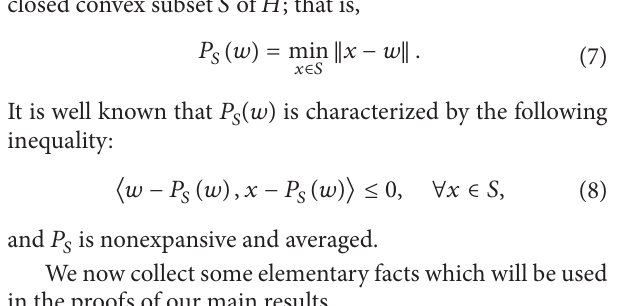
Algorithm 5. Choose an arbitrary initial point 𝑤 0 = (𝑥 0 , 𝑦 0 )